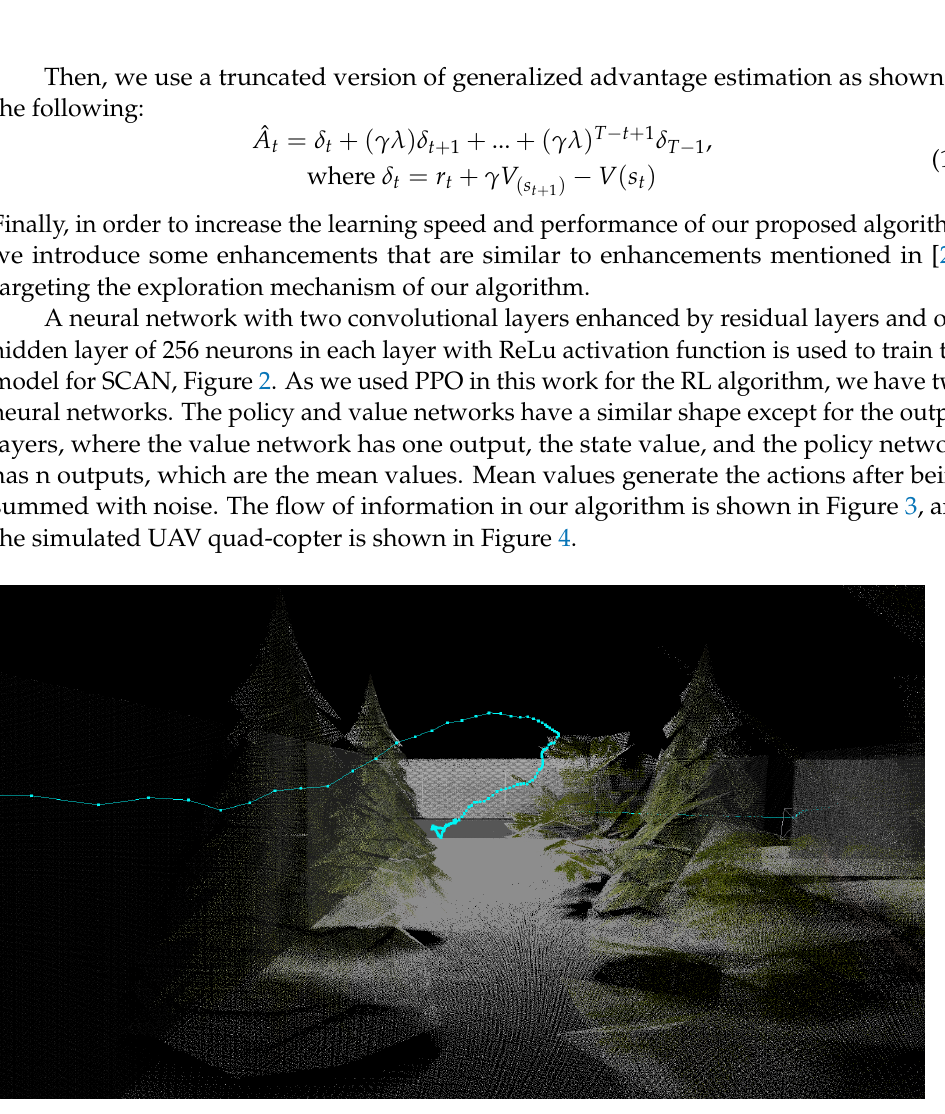
Figure 1. Trajectory of the UAV controlled by our proposed algorithm (SCAN). SCAN is able to control the UAV in three dimensions (X, Y, and Z). The image is generated by the SLAM approach (only used for visualization purpose) explained in the Section 4.3.1 of this paper.